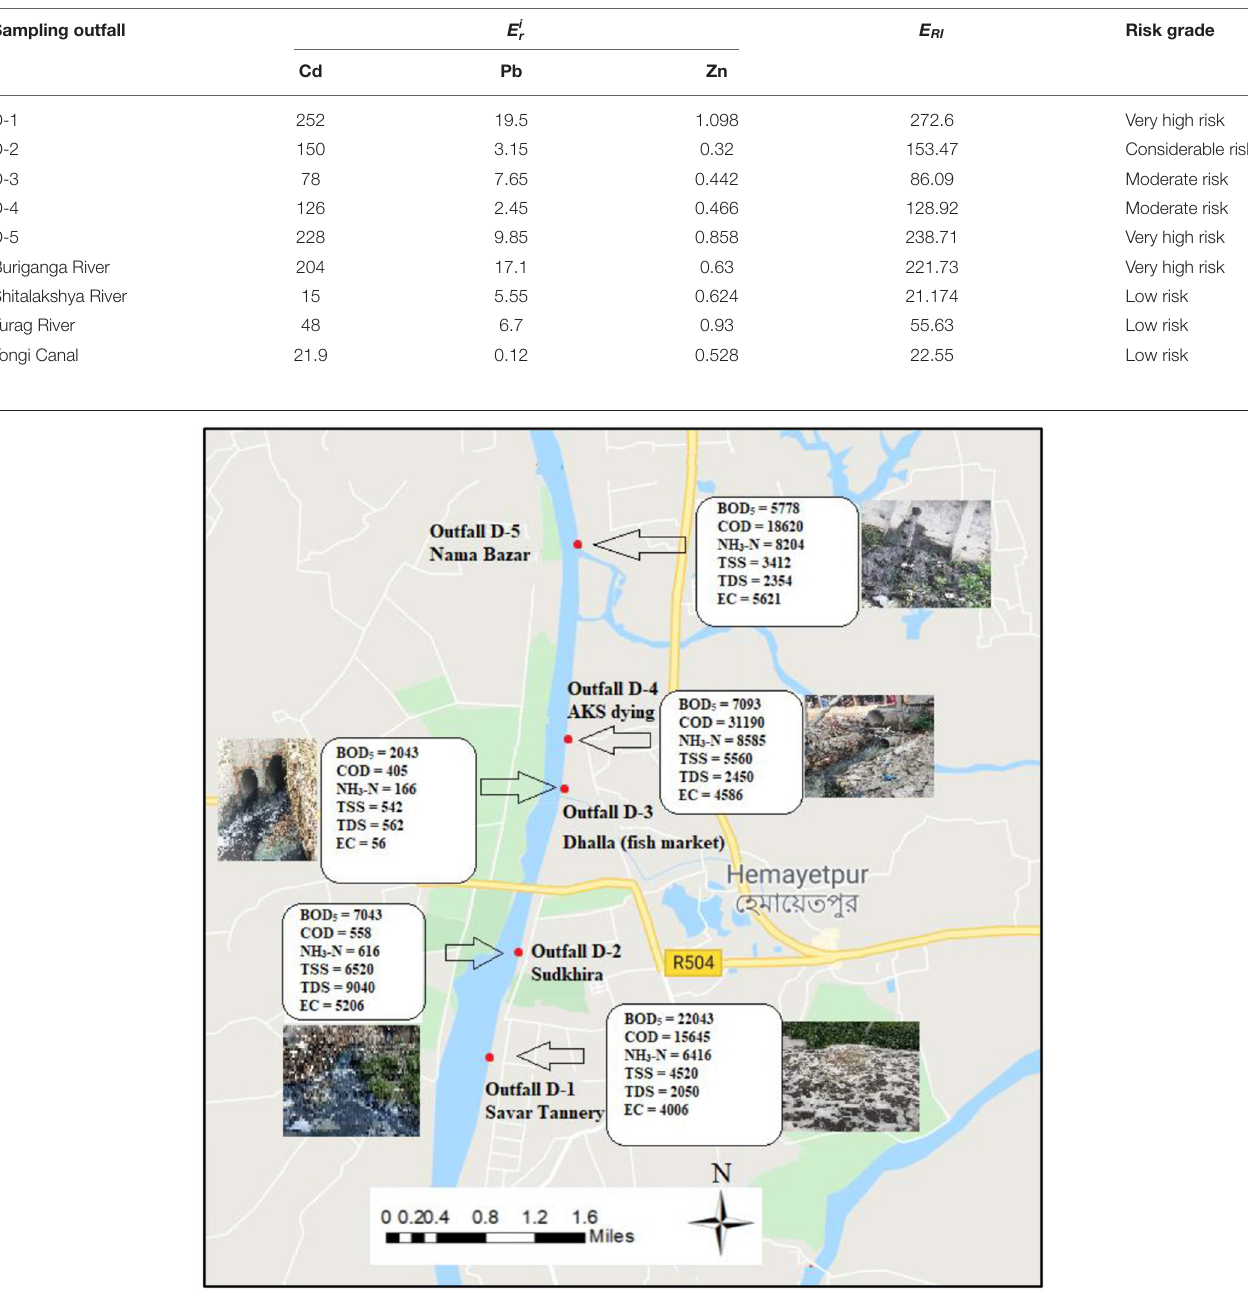
FIGURE 8 | Waste load contribution in Dhaleshwari